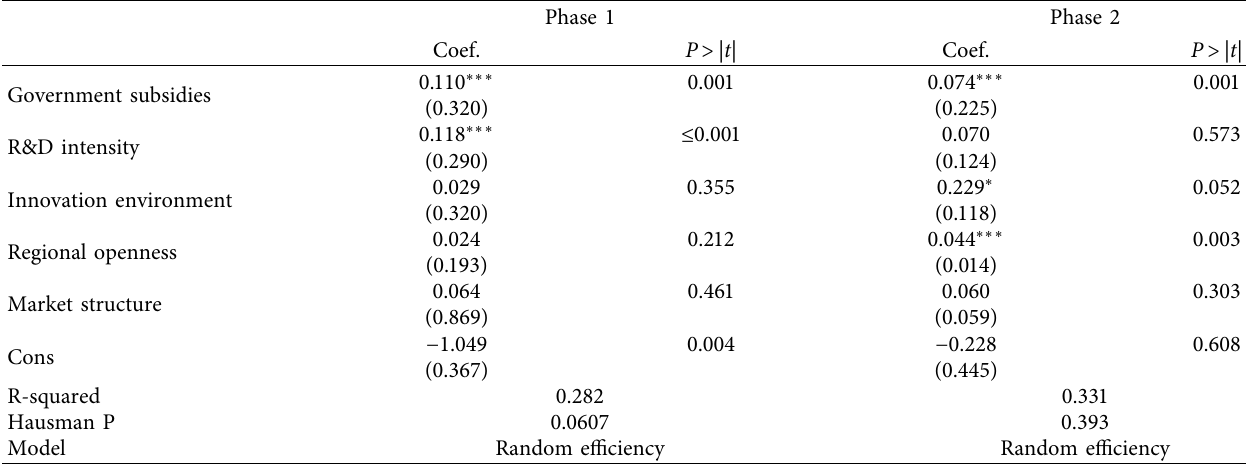
Table 3: Influence factor of innovation efficiency of the high-tech industry in Yangtze River economic